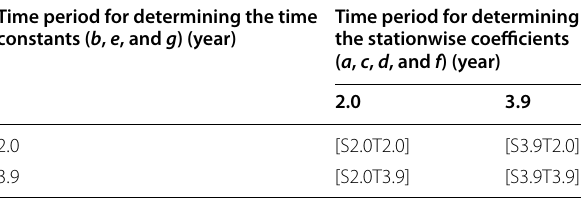
Table 3 Combinations of different time periods and their